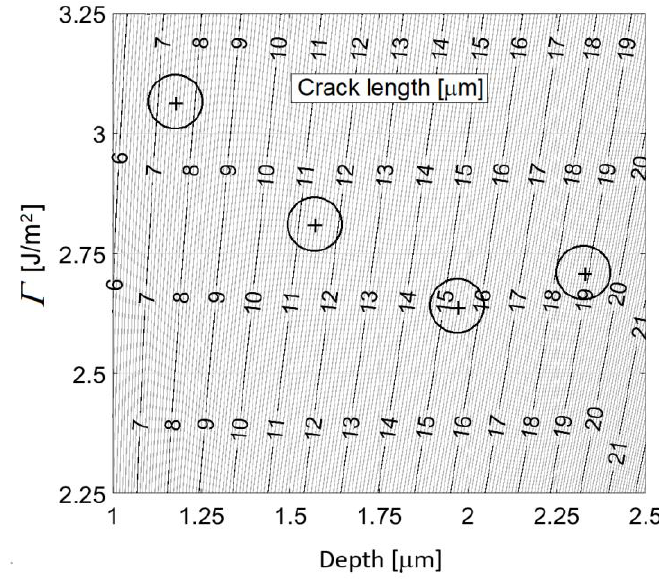
Figure 6. Crack length as function of the indentation depth and the cohesive energy density.